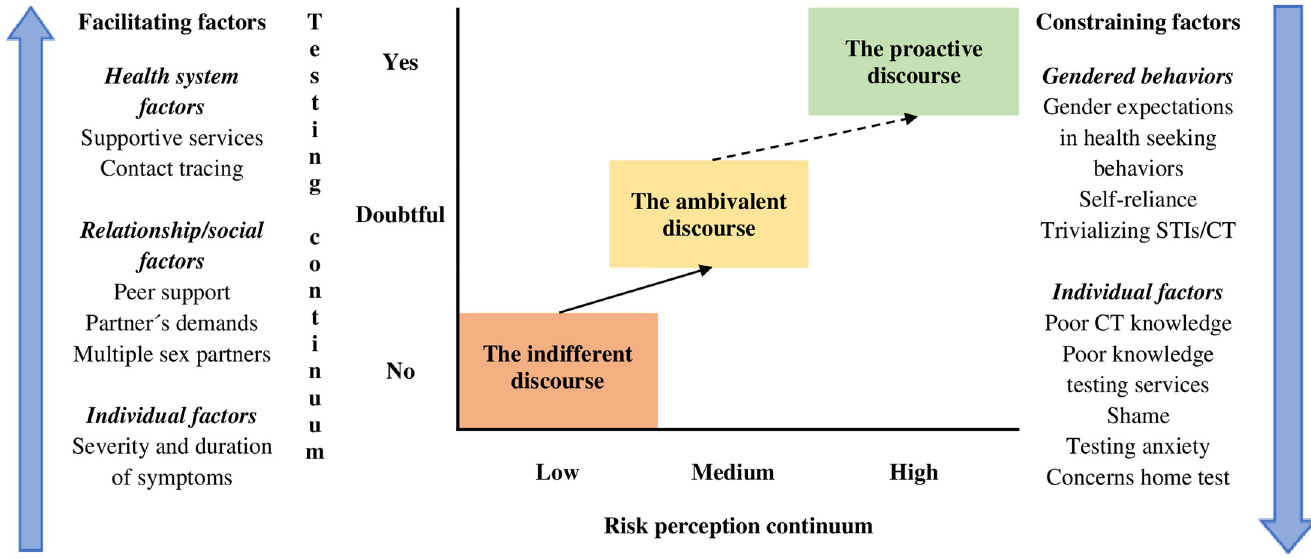
Fig 1. Young men’s discourses related to C . trachomatis testing. Positional map over how Swedish you men´s discourses overlap and differ within two continuums of variation: Own risk perception of getting infected with CT and attitude toward testing continuums.